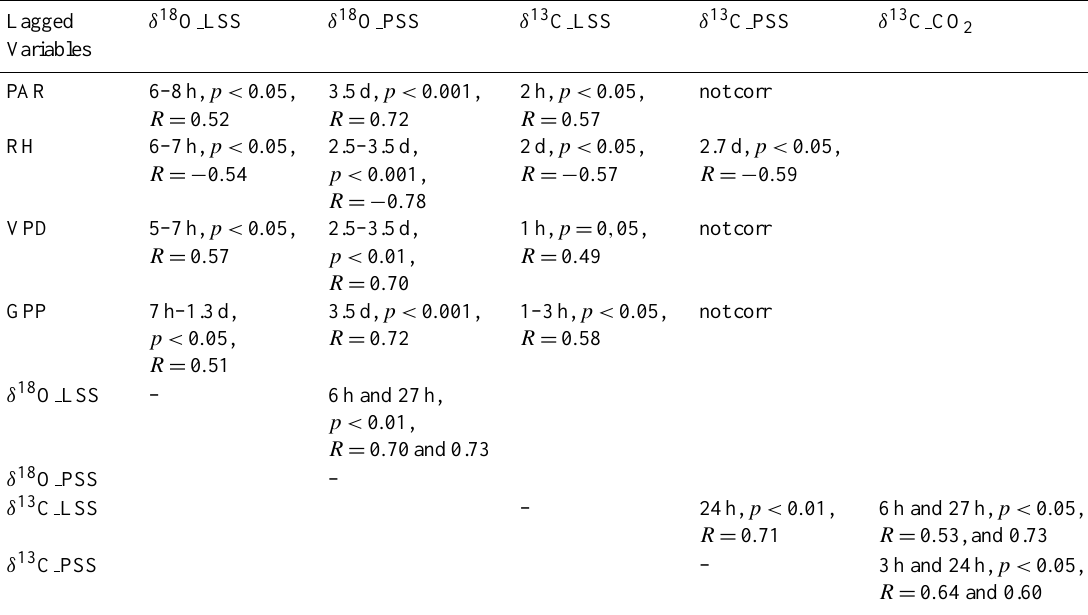
Table 1. Parameters of correlation (lag, corresponding to the highest correlation (in days and hours), significance of correlation and Pearson correlation coefficient ( R )) between isotopic composition ( δ 18 O and δ 13 C) in pools (top crown and phloem sugars) and fluxes (soil respired CO 2 ) and physiological and environmental factors. PAR-photosynthetic active radiation, RH – relative humidity of the air, VPD – vapour pressure deficit, GPP – gross primary production. Not corr – not correlated.